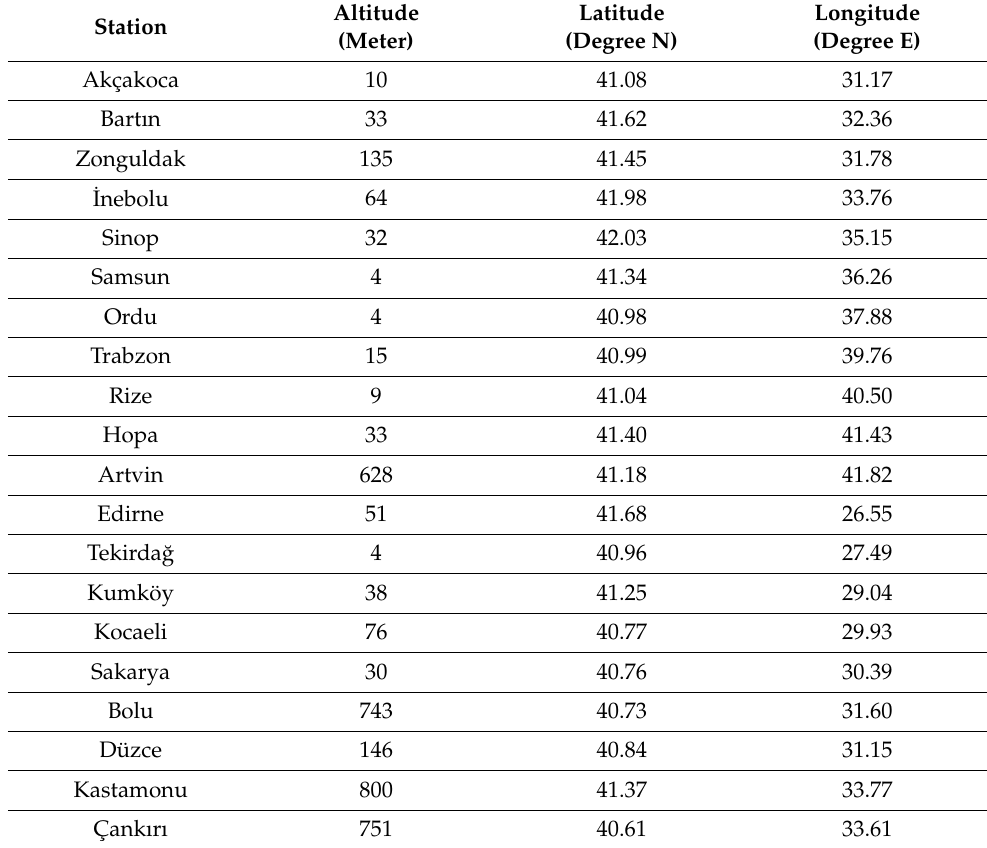
Figure 1. The stations used in the study. Table 1. The altitude, latitude and longitude of the